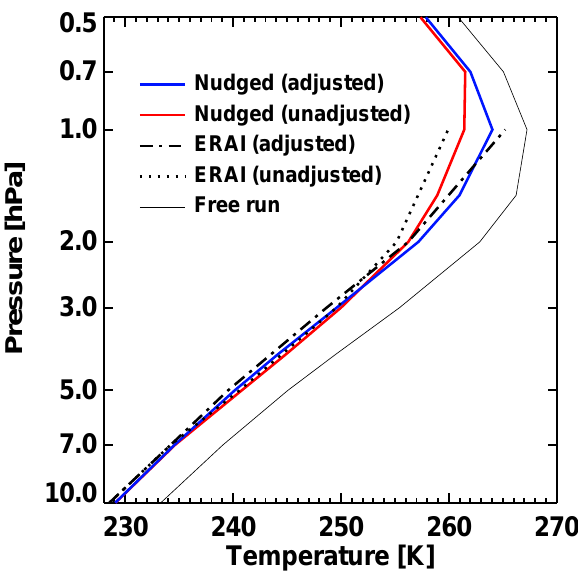
Fig. 6. Global mean temperatures averaged from 1986 to 1997: ad- justed (blue) and unadjusted (red) nudged runs; adjusted (dash-dot) and unadjusted (dots) ERA-Interim; free run (solid black).